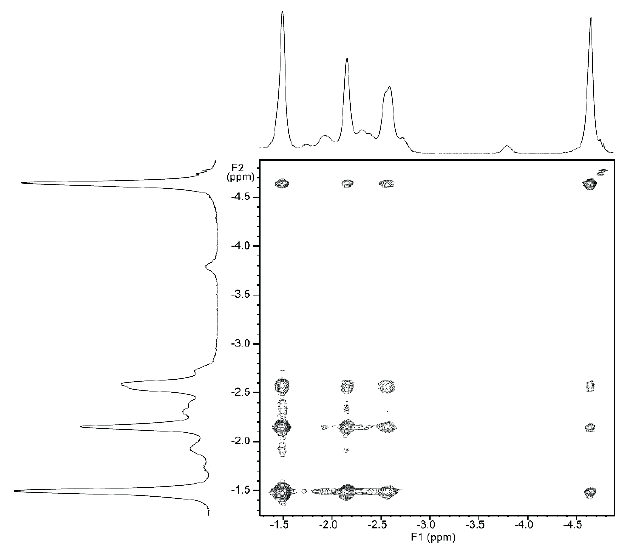
Figure 9. Expansion from TOCSY spectrum of a ≈ 1:1 complex of enediyne tweezer Z- 1 and 1,6-diaminohexane 21 (500 MHz, CDCl 3 . solution, ´ 40 ˝ C).